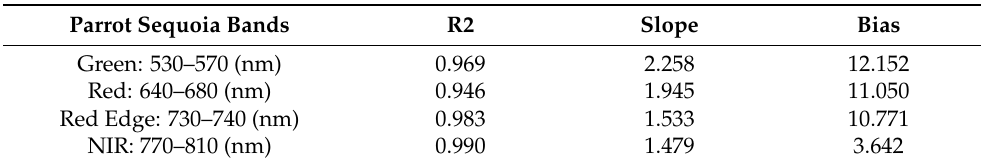
Figure 9. Spectral-dependent linear regression plots for Parrot Sequoia bands, between twin targets (n = 7) located in diffuse illumination conditions and direct illumination conditions. All regressions show an R 2 higher than 0.90 and a p -value < 0.01; additionally, note the reasonably good distribution along the [0, 100] % of reflectance values (also for all spectral bands). These empirical line functions were applied to all the detected shadowed pixels to enhance their radiometry and obtain de-shadowed pixels. Table 4. Linear regressions to fit shadowed reflectance panels to the reflectance of the non-shadowed panels for the Parrot Sequoia camera (case study).